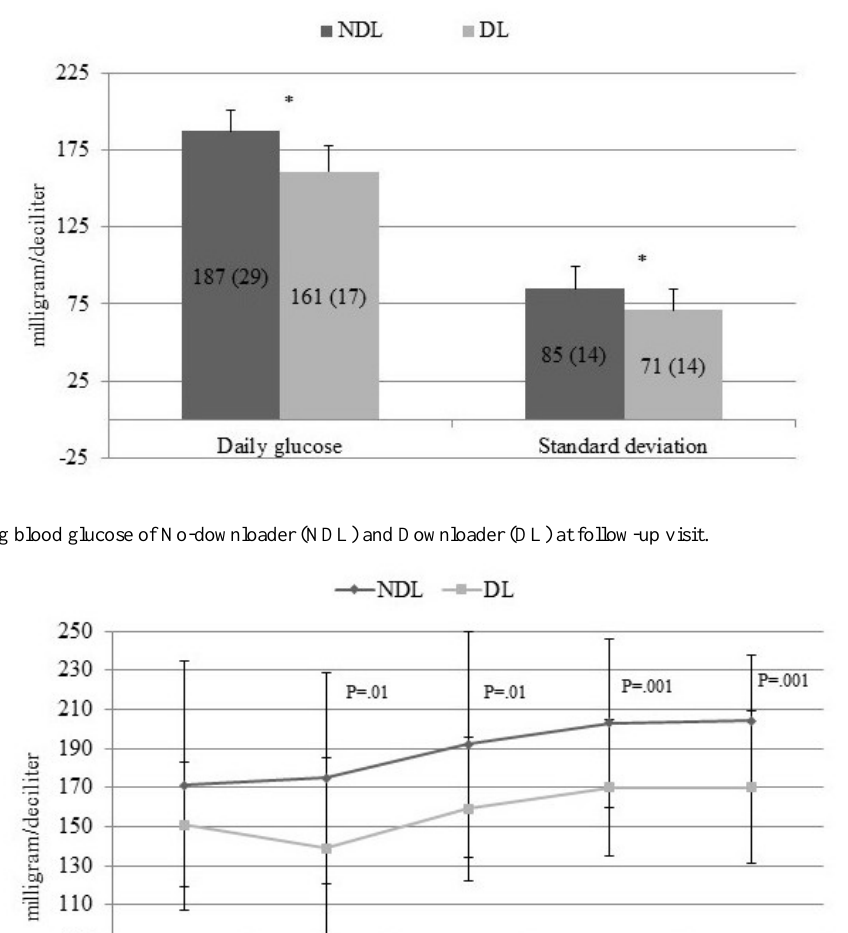
Figure 2. Mean (SD) daily glucose and mean standard deviation of No-downloader (NDL) and Downloader (DL) at follow-up visit. *P=.001.